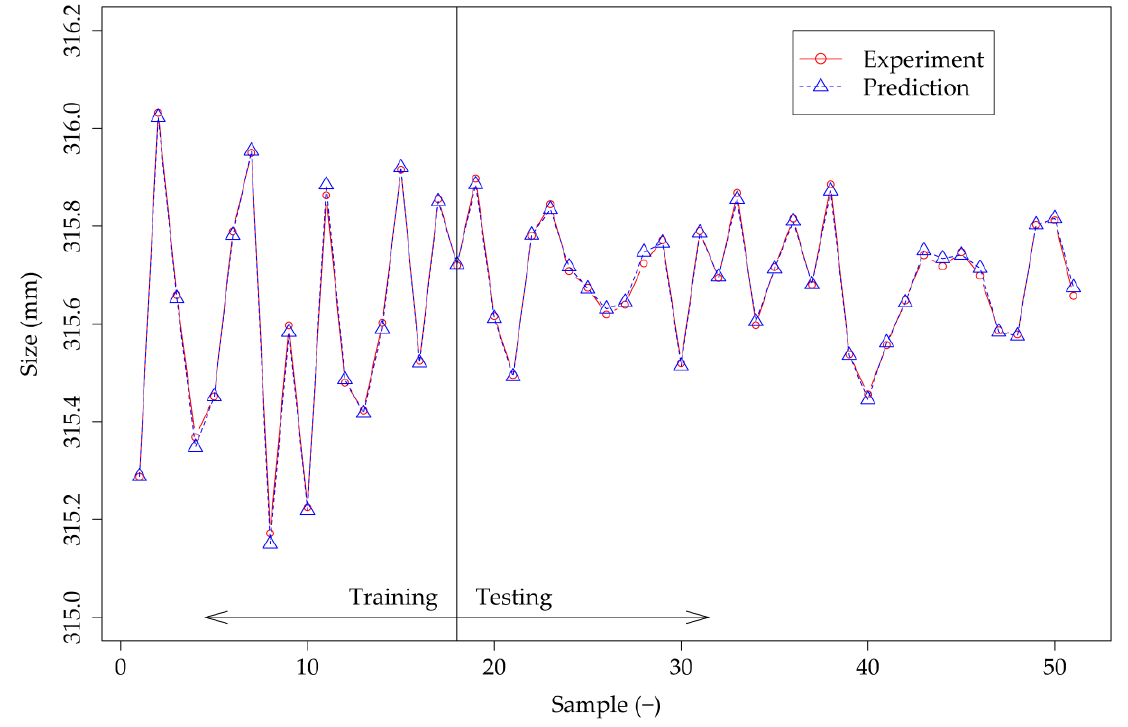
Figure 9. Comparison between prediction and experiment data for BRANN. Regression plots for LMANN and BRANN are shown in Figures 10 and 11.